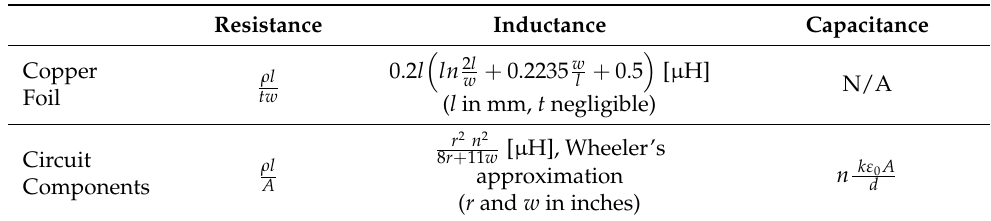
Table 5. Electrical properties of copper foil (rectangular) and passive components (assumed circular)